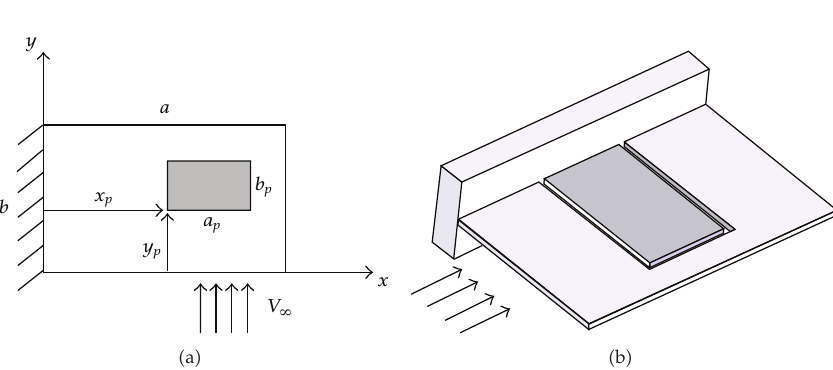
Figure 1: (cid:3) a (cid:6) A cantilevered plate with a bonded patch and subjected to a lateral supersonic flow as well as (cid:3) b (cid:6) a ba ffl ed